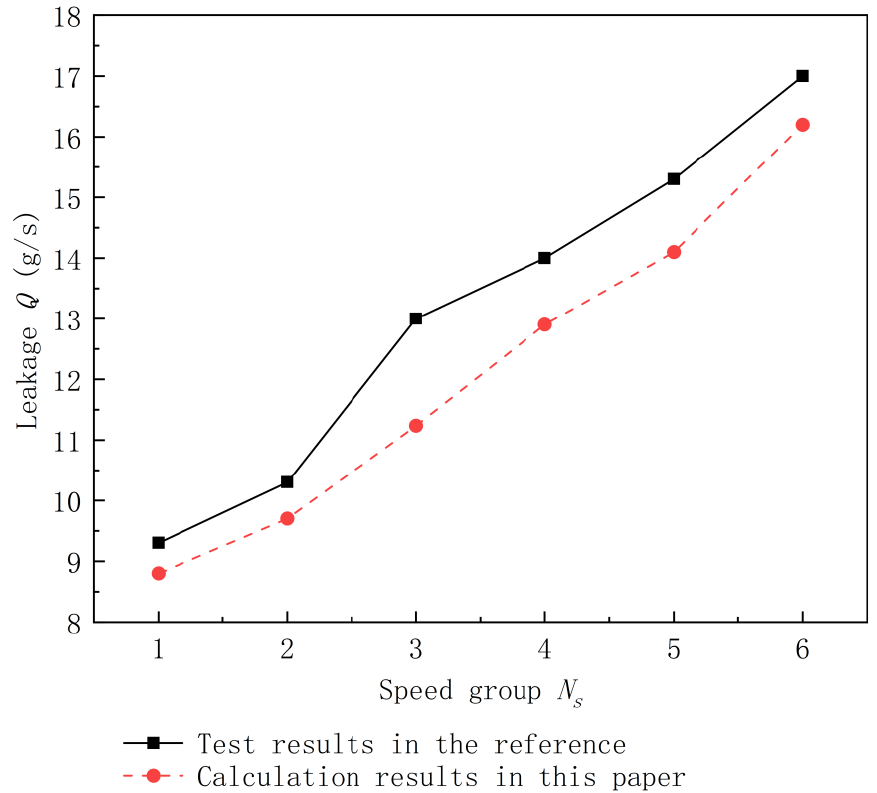
Figure 4. Comparison of numerical calculation results and test results.